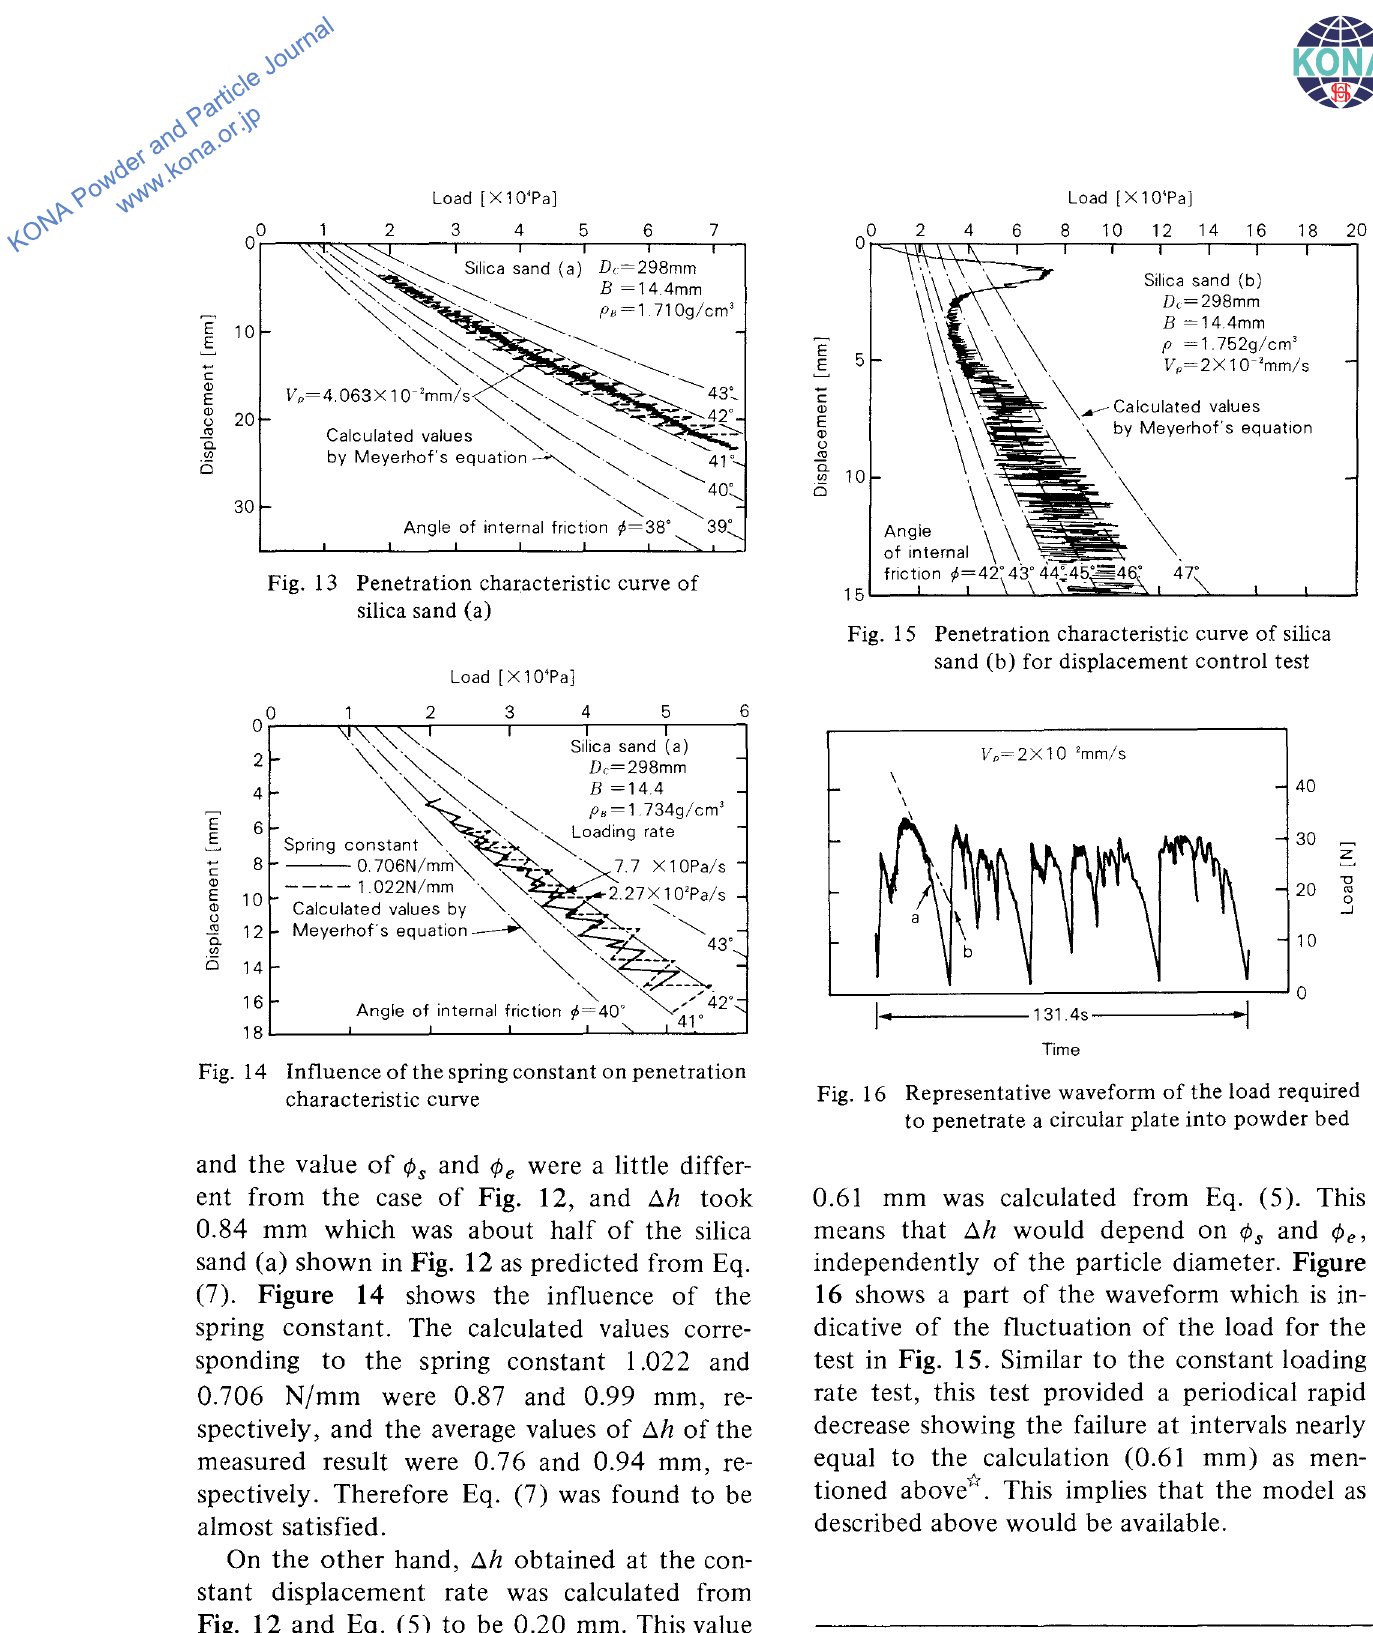
Fig. 13 Penetration characteristic curve of silica sand (a)